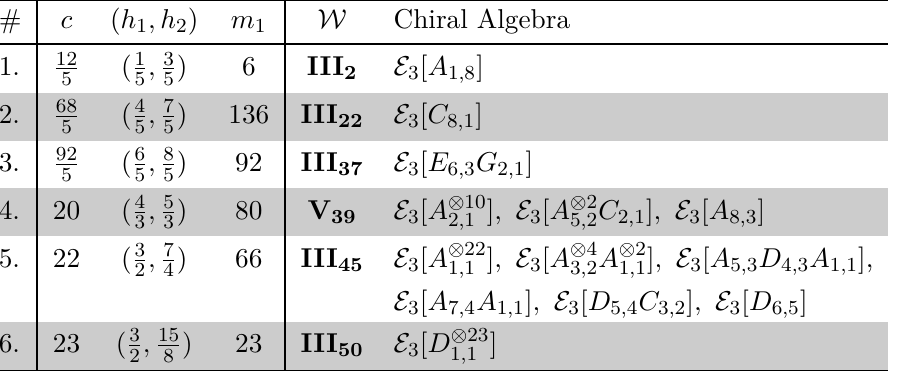
Table 27. Consistent CFTs of type III and V